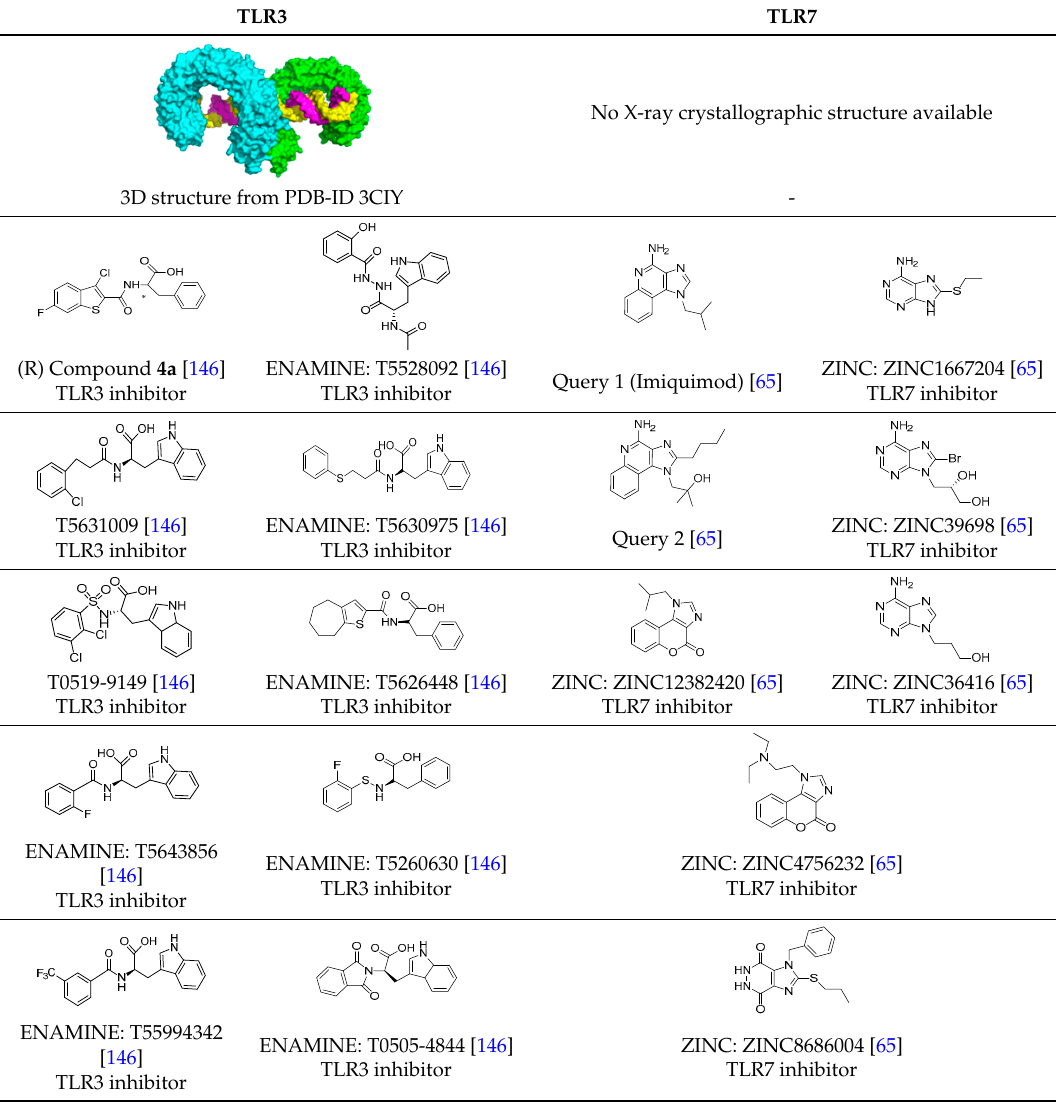
Table 3. 2D Chemical structure of TLR3 and TLR7 modulators identified by VS techniques and mentioned in this review. The database codes are provided.